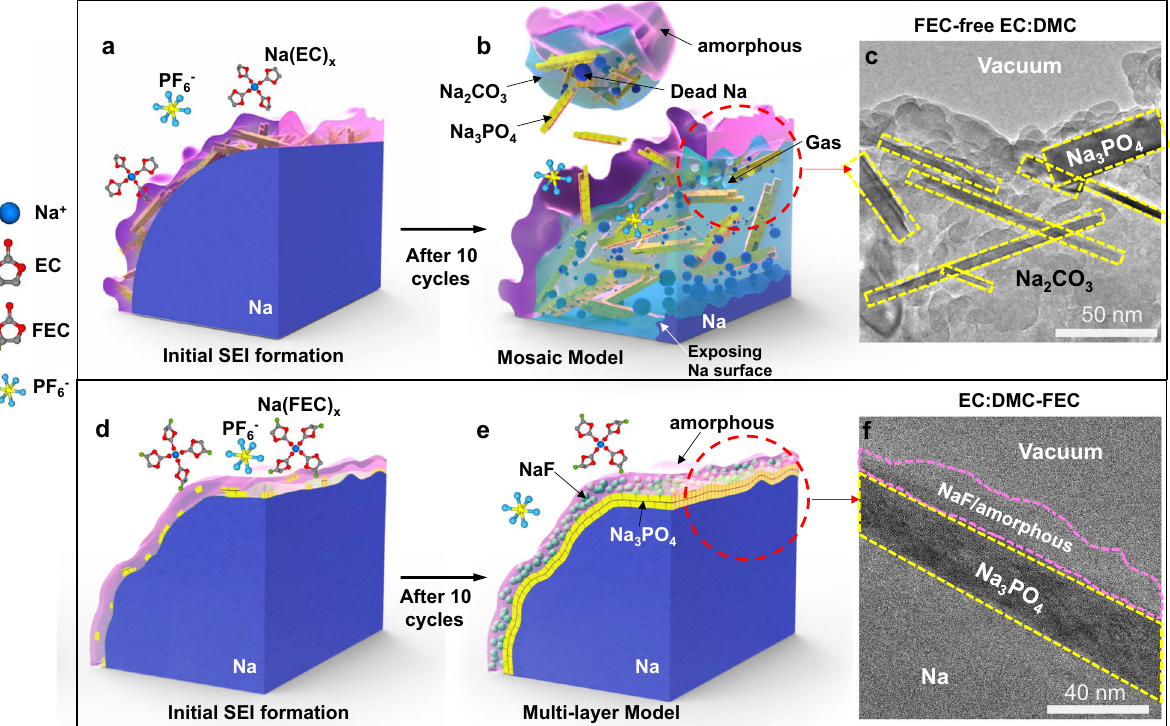
Fig. 6 Representation of the SEIs formation during cycling. ( a ) Schematic drawings of the initial SEI nucleation at the 1st cycle and fi nal structure at the 10th cycle, b and corresponding cryo-TEM image after ten cycles in the FEC free EC:DMC electrolyte ( c ). Schematic drawings of the initial SEI nucleation at the 1st cycle ( d ) and fi nal structure at the 10th cycle ( e ) and corresponding cryo-TEM image after ten cycles in the EC:DMC-FEC electrolyte ( f ). ef fi ciency and cycling life. This work highlights the use of low-dosage limited sodium source in the cell and posing potential safety hazards. cryo-TEM to directly image the SEI and Na dendrite at the atomic With the addition of FEC, the FEC-Na metal reaction produces scale, and explain the functional origin of FEC additives for enhanced dense and continuous layers of Na 3 PO 4 and NaF, which cover the Na cell performance. In doing so, it also provides useful insights into the metal and prevent reactions between the Na metal and electrolyte. Therefore, FEC additive can greatly improve the cell ’ s Coulombic impact of electrolyte additives on the stability of Na-metal cells. NATURE COMMUNICATIONS| (2021) 12:3066